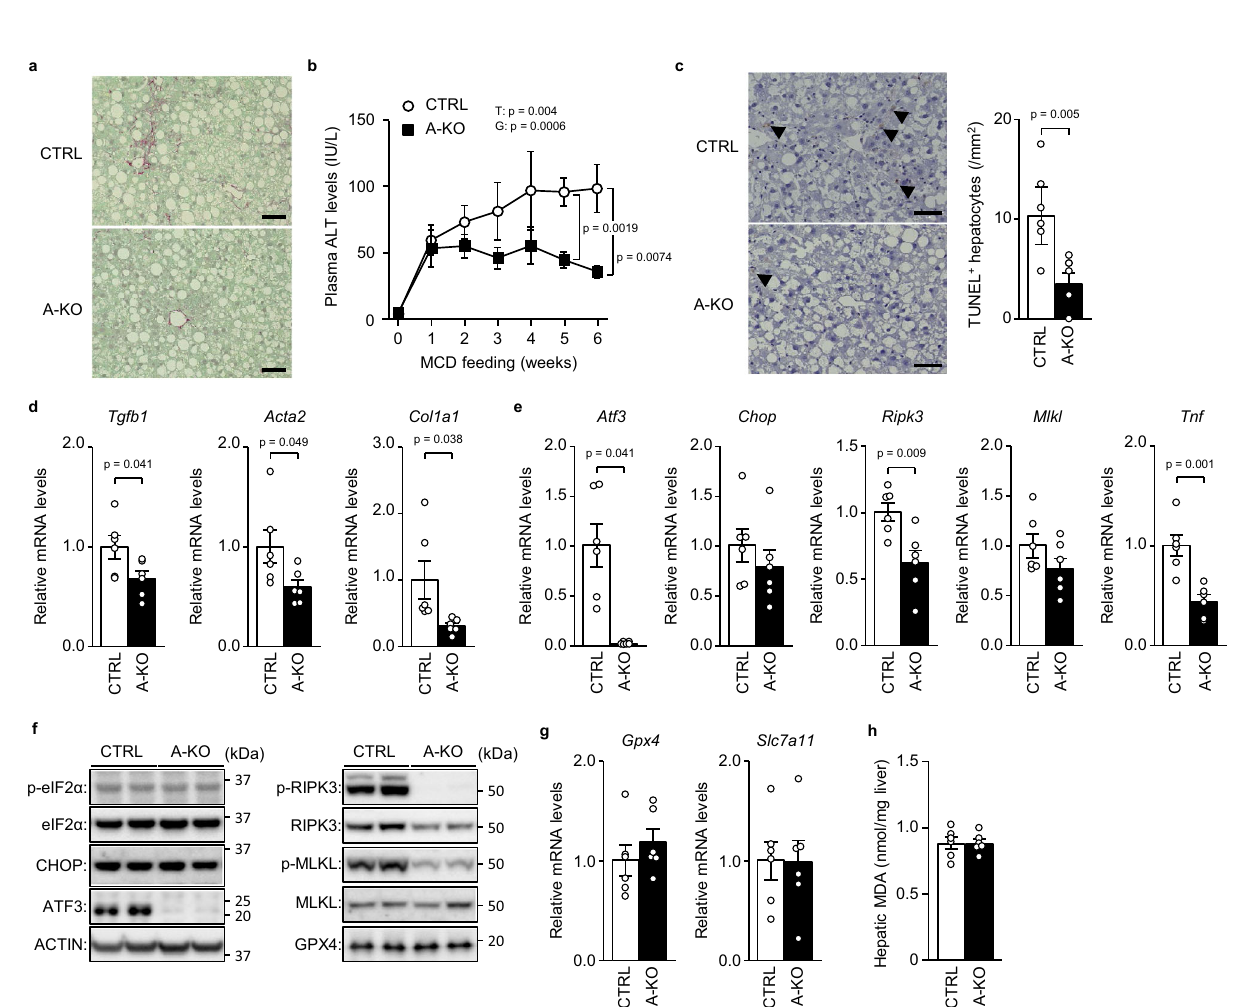
Fig.8|RIPK3knockdownamelioratesNASHinducedbyMCDfeeding.a , b Wild- type mice were treated as indicated. a Immunoblot analysis. b Quantitative PCR analysis. c , d ISHfor Atf3 and Ripk3 . c ISHimagesofserialsections.Scalebar,50 μ m. Arrows indicate both Atf3 + and Ripk3 + hepatocytes. Arrowheads indicate Atf3 + or Ripk3 + hepatocytes. Asterisks indicate hemosiderin pigmentation. d Percentage of Ripk3 + orRipk3 − hepatocytesin Atf3 + hepatocytes(left).PercentageofAtf3 + orAtf3 − hepatocytes in Ripk3 + hepatocytes (right). e – j Ripk3 siRNA was injected into the mice at 2 and 4 weeks after MCD feeding. e Plasma ALT levels. f TUNEL staining (left).Scalebar,50 μ m.NumberofTUNEL + hepatocytes(right). g Siriusredstaining.